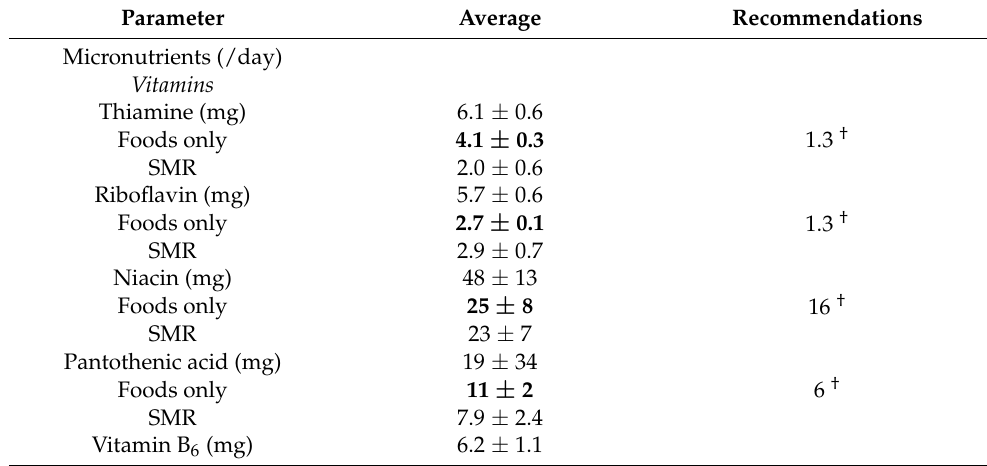
Table 3. Intake of selected vitamins, minerals, and trace